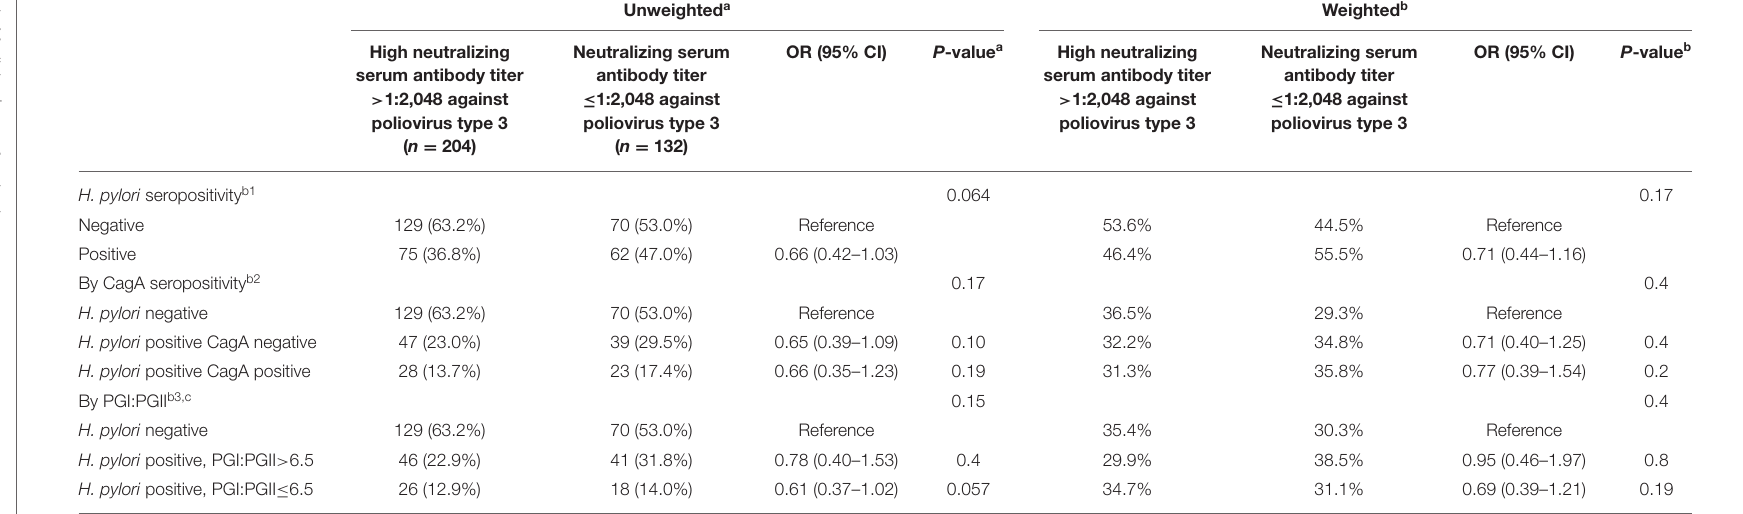
TABLE 3 | Associations of H. pylori IgG seropositivity and serum pepsinogens, with high serum neutralizing antibody level against poliovirus type 3 vaccine strain. Unweighted a Weighted